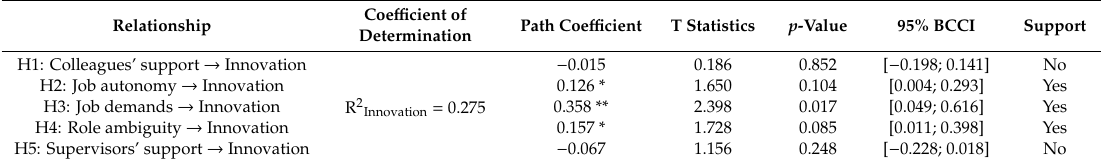
Table 2. Structural model results.